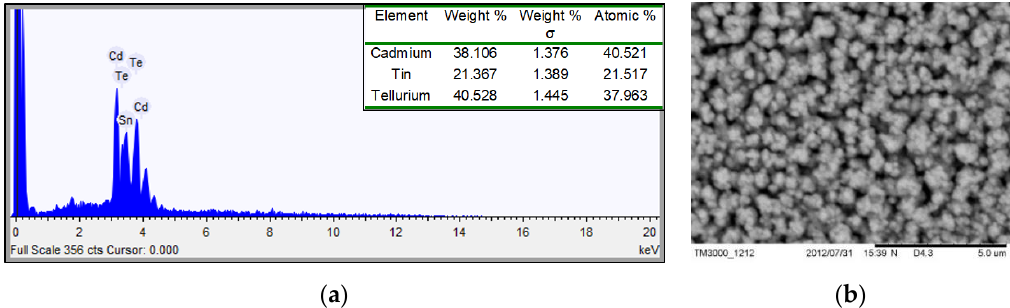
Figure 9. Material characterisation of deposited CdTe using the S-1 configuration for the chamberless coating head; results are displayed as ( a ) EDX result, presenting an elemental composition of the measured sample, and ( b ) SEM results, showing the surface topology and grain structure of CdTe deposited